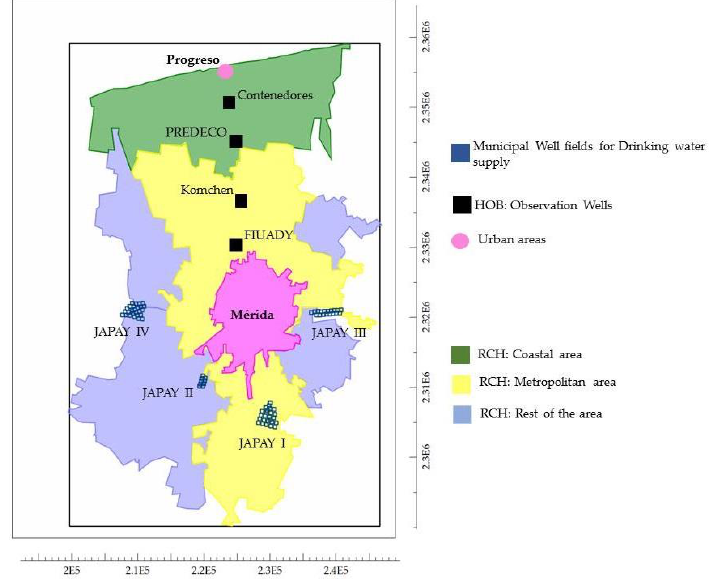
Figure 3. Locations of well fields, monitoring wells with the spatial distribution of the recharge package. Axis X and Y display UTM coordinates in meters.